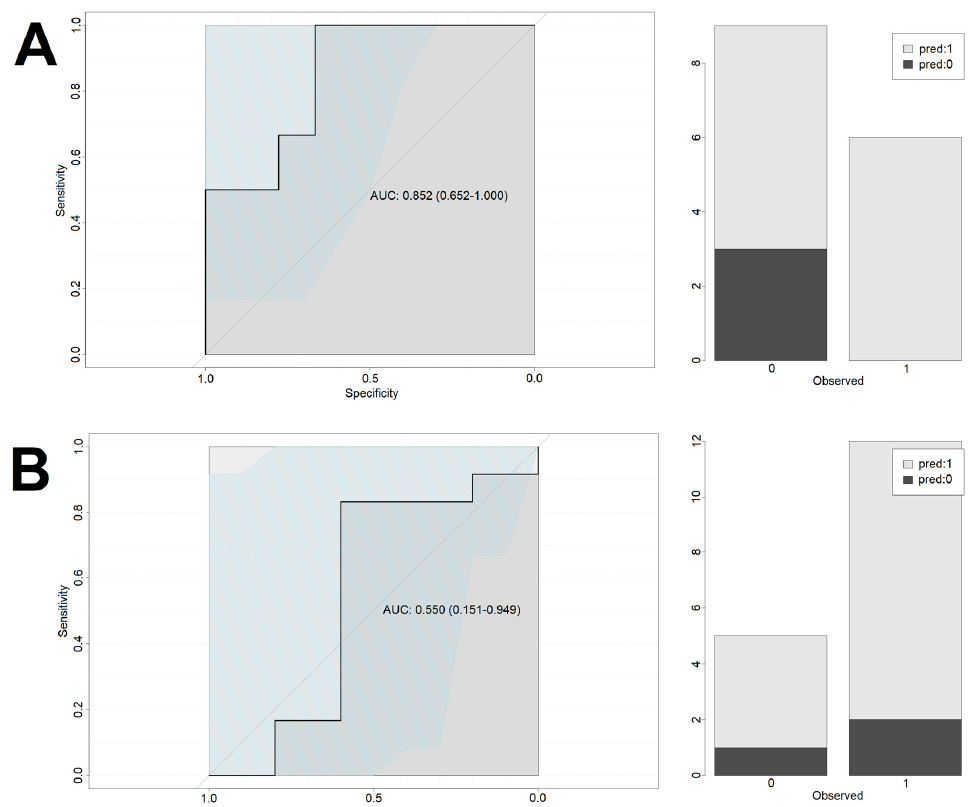
Figure 6. Performance of the cortisol-based model with confounding factors on the test set. Left column depicts the ROC curves of the logistic regression models. Right column shows the accuracy of predictions on the test set based on the cut-off determined using the training set. X -axis describes the real outcomes. Colors describe the predicted outcomes. Y -axis depicts counts. 0—Lack of endpoint fulfillment; 1—endpoint fulfillment. ( A ) NGCG group. ( B ) GCG